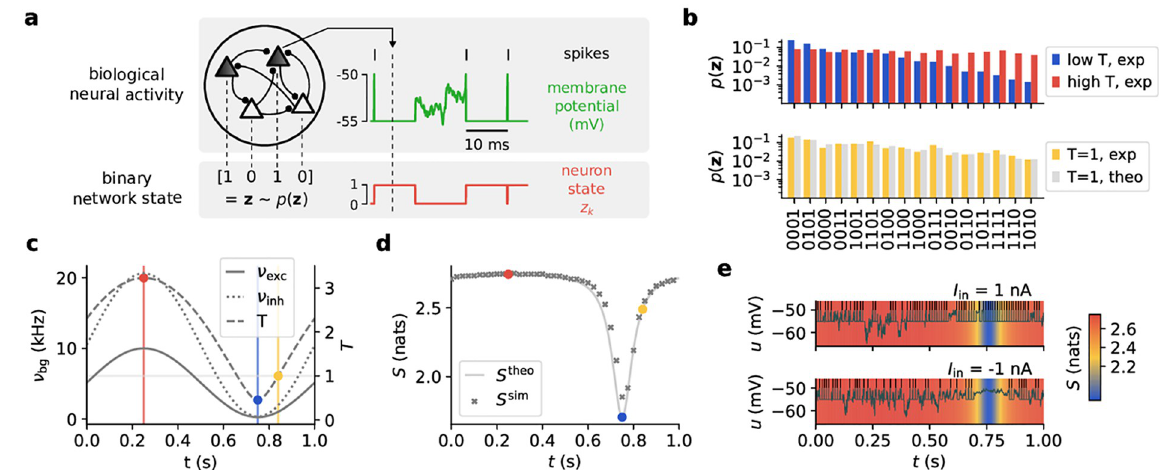
Fig 2. Effects of oscillatory background activity on sampled distributions. (a) Network dynamics. Each neuron encodes a binary random variable according to its refractoriness. When the membrane potential (green) is clamped to the reset value, the neuron state (red) is considered to be z = 1 ( z = 0 otherwise). The collection of the resulting network states z forms an estimate for the implemented probability distribution p ( z ). (b) Distributions sampled by a 4-neuron network at the three temperatures marked in (c). States are ordered according to their respective probabilities at the low temperature to emphasize the effect of tempering visually. (c) Time course of excitatory and inhibitory background rates (dashed and dotted lines, Eq 10), along with the associated temperature (solid line, Eq 4). Note that ν exc is scaled by 0.5 and w exc by the square root of the inverse scaling factor to demonstrate that balance is independent of such a rescaling. (d) Simulated (crosses) vs. calculated (solid line) entropy course S ( t ). The slight lag is due to the finite relaxation time constants τ s , τ ref of the network (Eq 35 only holds strictly for quasi-static temperature changes). (e) Effect of tempering on individual membrane potentials and spiking activity. The background color represents the corresponding